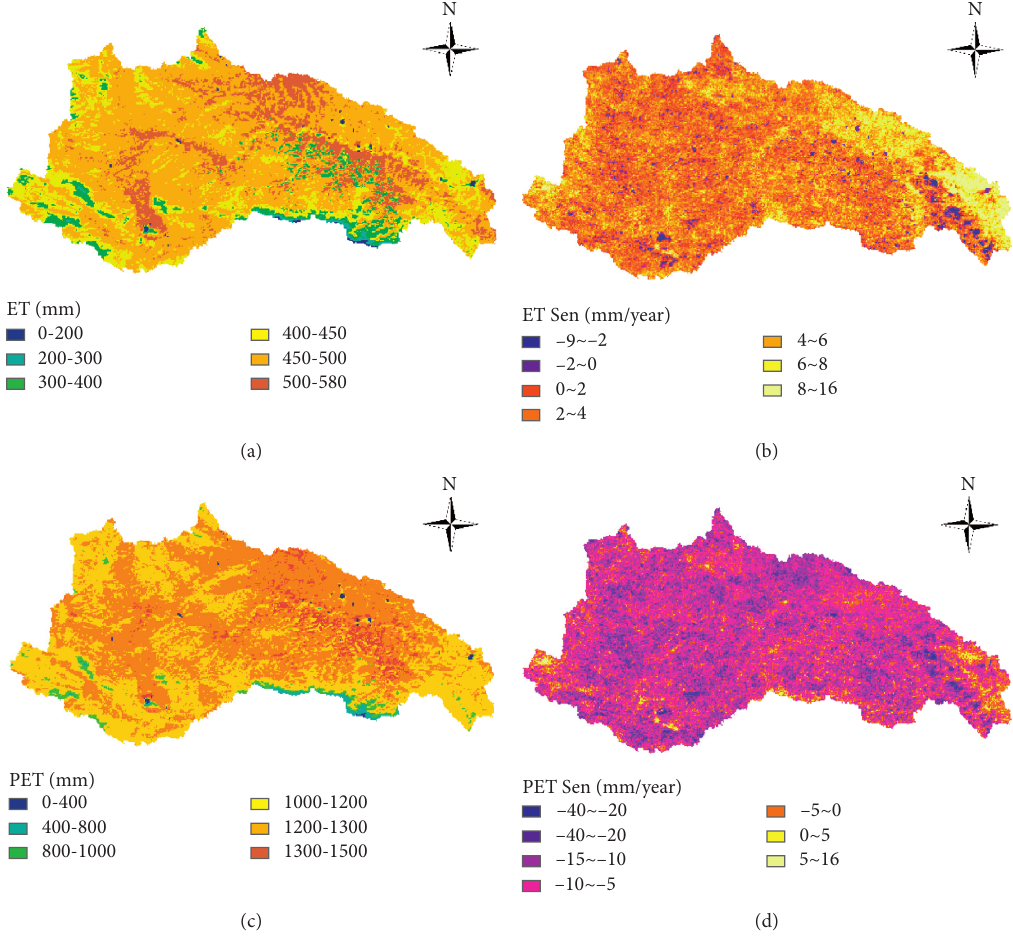
Figure 8: Spatial distributions based on MOD16 data and change rates of ET (a and b) and PET (c and d) over the upper Taohe River basin from 2001 to